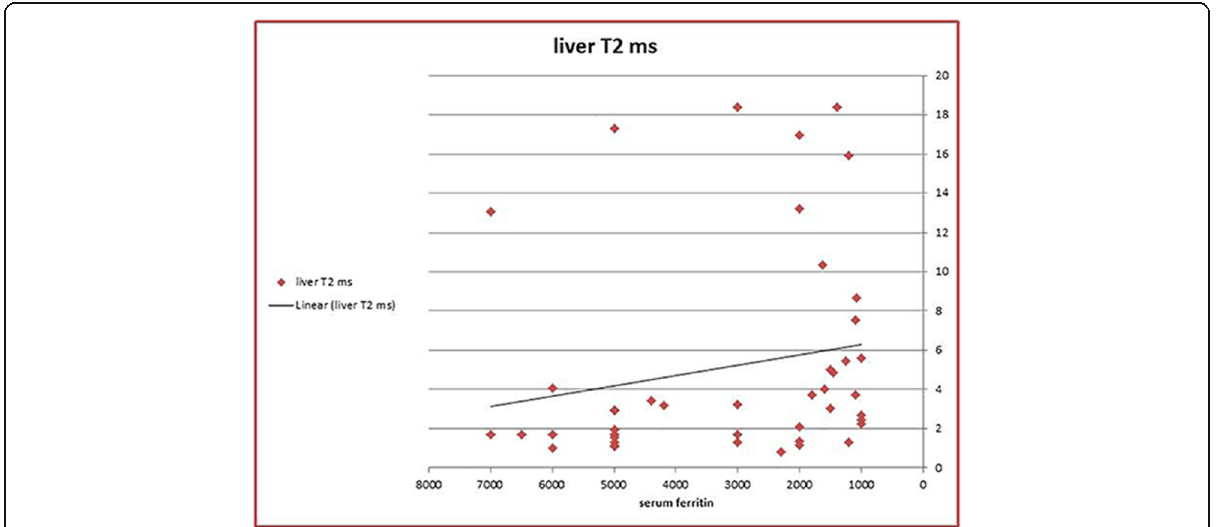
Fig. 3 Scatter plot with line chart for negative correlation between hepatic T2 and serum